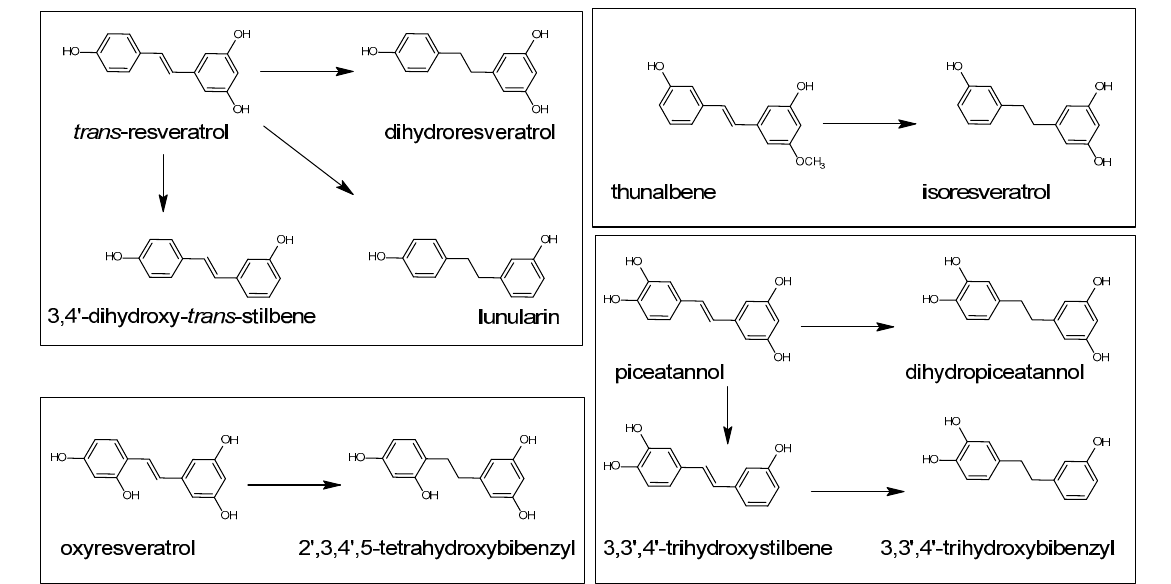
Figure 19. The effect of bacterial metabolism on resveratrol, oxyresveratrol, thunalbene and piceatannol. Based on [320,324].